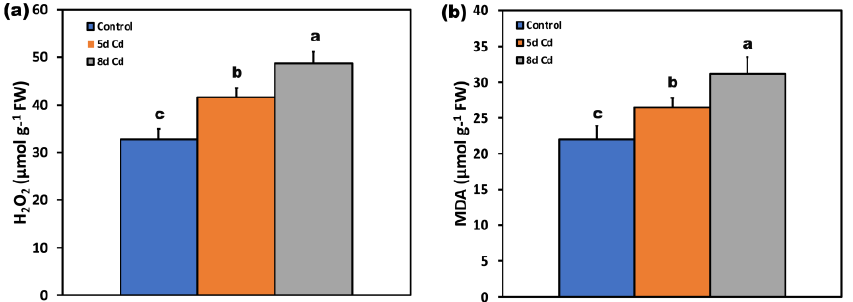
Figure 11. Changes in hydrogen peroxide (H 2 O 2 ) generation ( a ), and lipid peroxidation production ( b ), in the leaves of Salvia sclarea control (con), and 5- and 8-days Cd-treated plants. Error bars are standard deviations ( n = 6). Columns with different letters are statistically different ( p < 0.05).